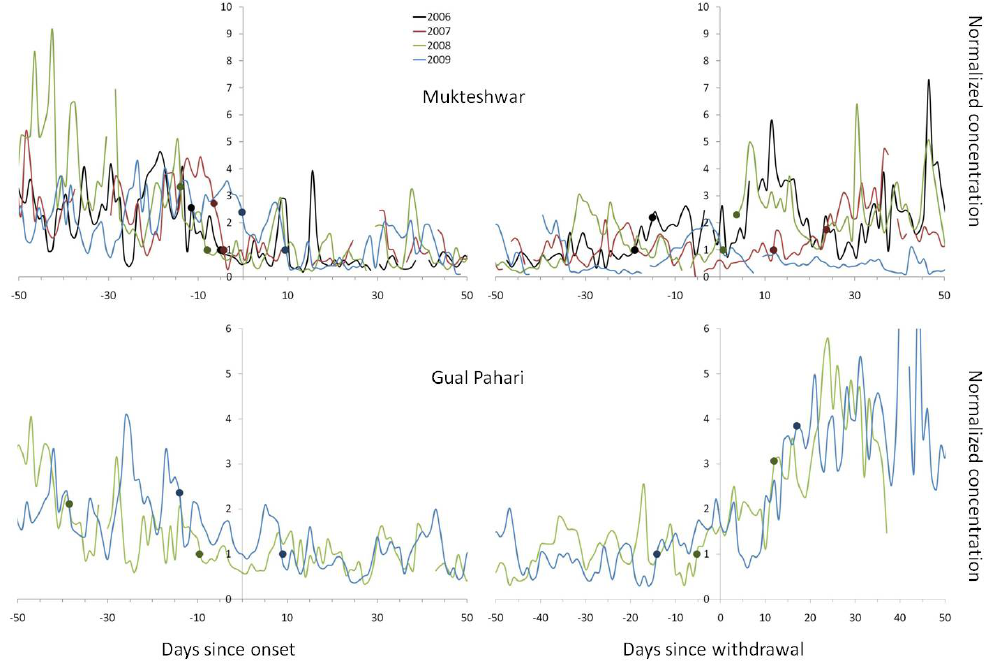
Fig. 6. Transient periods between the pre-monsoon/monsoon and monsoon/post-monsoon season at Mukteshwar and Gual Pahari. Relative concentrations are 24-h averages of normalized PM 2 . 5 , PM 10 and BCe concentrations with annual monsoon means set to unity for each property. Dots mark the beginning and ending of the transient periods. See text for details.